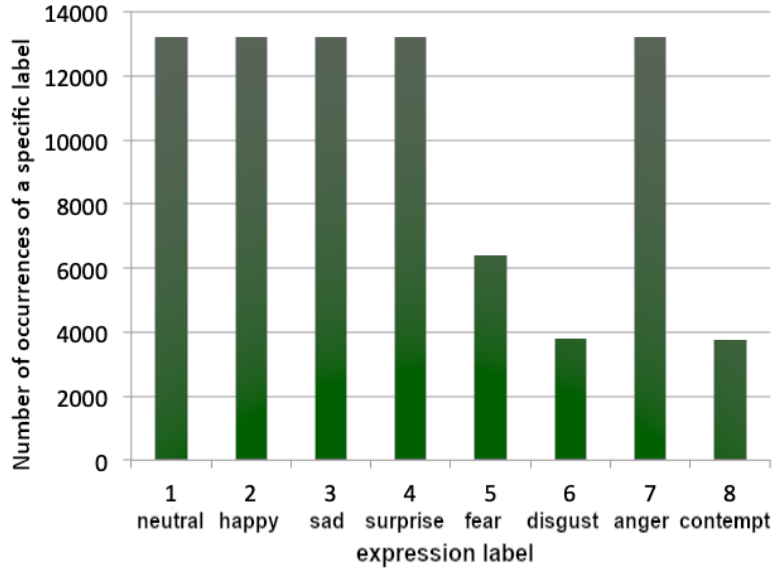
Figure 1. Data distribution of 80,000 images trimmed to avoid overrepresentation.